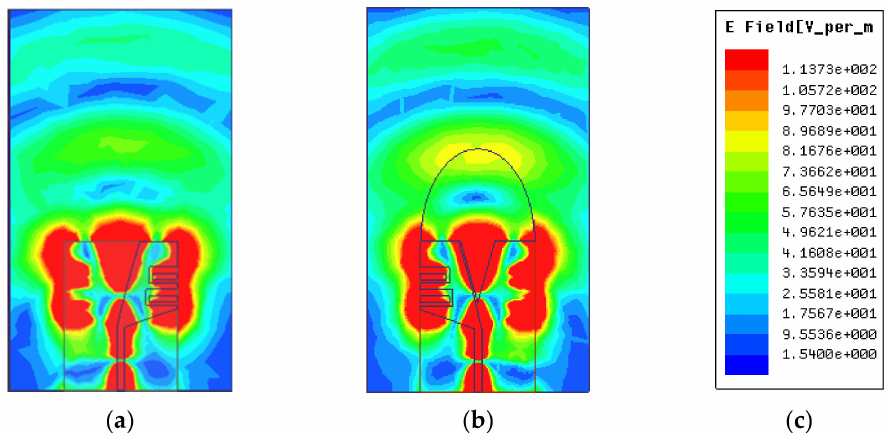
Figure 6. E-field distribution inside substrate of the TSA element at 10 GHz, ( a ) without dielectric lens, ( b ) with dielectric lens, and ( c ) relative value of electric field strength. The focus of the E-field obviously occurs on the axis of symmetry.